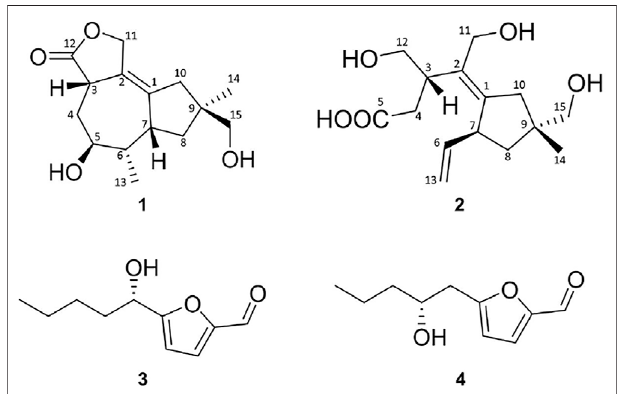
FIGURE 1 | Chemical structures of 1 – 4 .